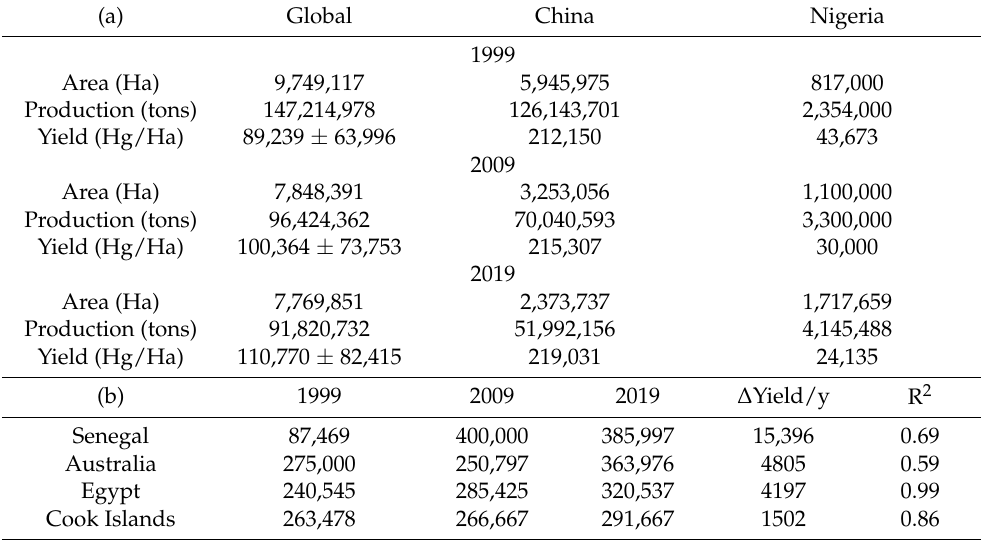
Table 1. Agricultural performance of sweet potatoes in two decades 1